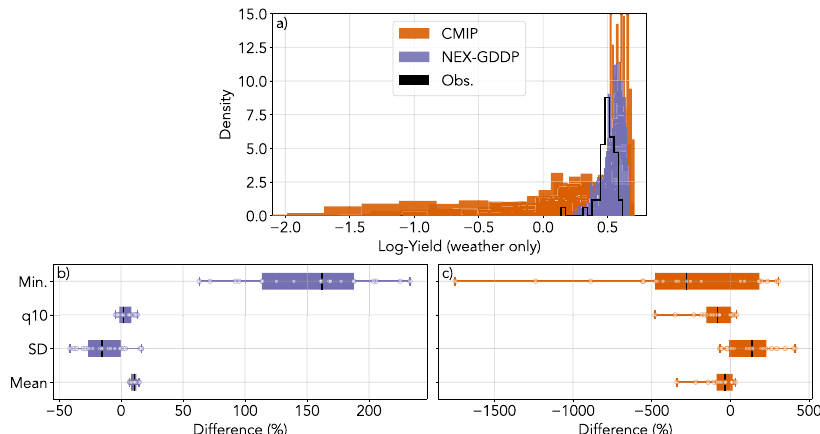
Fig. 1 National-level evaluation of NEX-GDDP and CMIP5 maize yield hindcasts. Panel a shows historical (1956 – 2005) national-level log-yield distributions from each CMIP5 model (orange), NEX-GDDP model (purple), and the observational data (black). Panel b shows percentage differences between each individual NEX-GDDP model and the observational data, for our chosen summary statistics: the mean, standard deviation (SD), 10th percentile (q10), and minimum (Min.). The boxes extend to the 25th and 75th percentile models, and the whiskers extend the full range of models. Panel c shows the equivalent to b but for the CMIP5